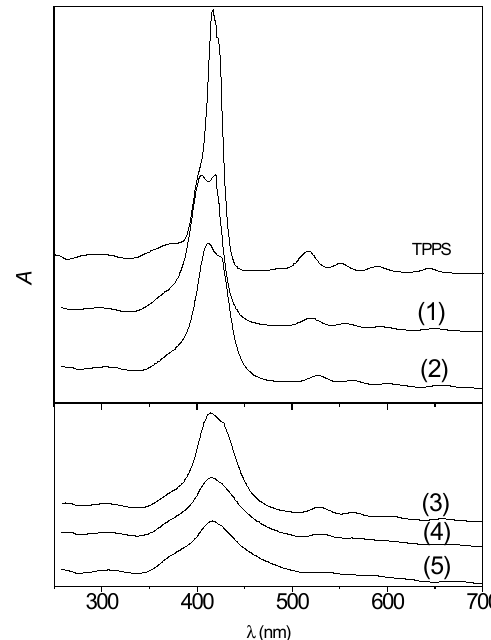
Figure 2. Absorption spectra of meso-tetrakis(4-sulfonatophenyl) porphine in formamide dispersions with LDH2. The ratios of the dye and LDH2 were 0.05(1), 0.10(2), 0.25(3), 0.40(4) and 0.50(5) mmol g -1